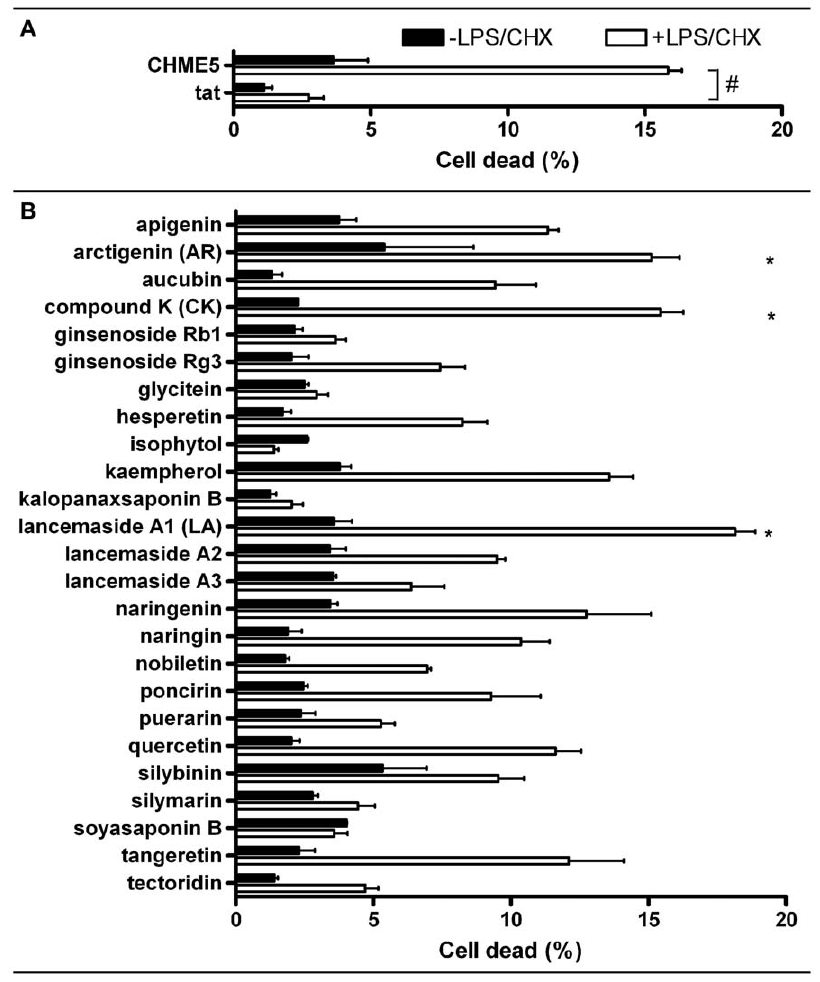
Figure 1. Compounds screened for inhibiting cytoprotective effect. ( A ) CHME5 control cells and Tat-expressing CHME5 cells were treated with (open bars) and without (closed bars) 50 m g/ml LPS and 10 m g/ml cycloheximide (LPS/CHX) to show the baseline level of death due to external stress ( , 3%). Induction of cell death by LPS/CHX stress is denoted by ‘‘ # ’’ for the CHME5 control cells. ( B ) The Tat-expressing CHME5 cells were treated with 25 different drugs (10 m M) in the presence or absence of LPS/CHX for 24 hours. Cell death was determined using the Live/Dead assay (Invitrogen). Arctigenin, Compound K and Lancemaside A1 were the most potent compounds that prevented the cytoprotective effect of Tat during LPS/CHX stress and are marked with asterisks (*). Data are plotted mean and SEM for 2–3 independent experiments for each